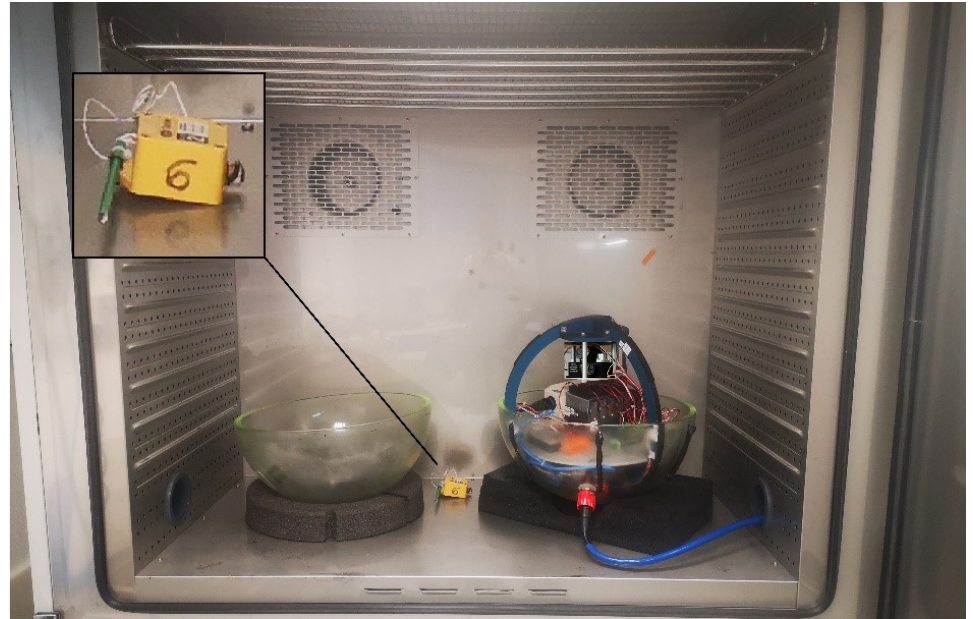
Figure 4. View of the GraviMob system inside the climate chamber. The thumbnail shows an enlarged view of the additional electronic thermometer used for monitoring temperature variations inside the